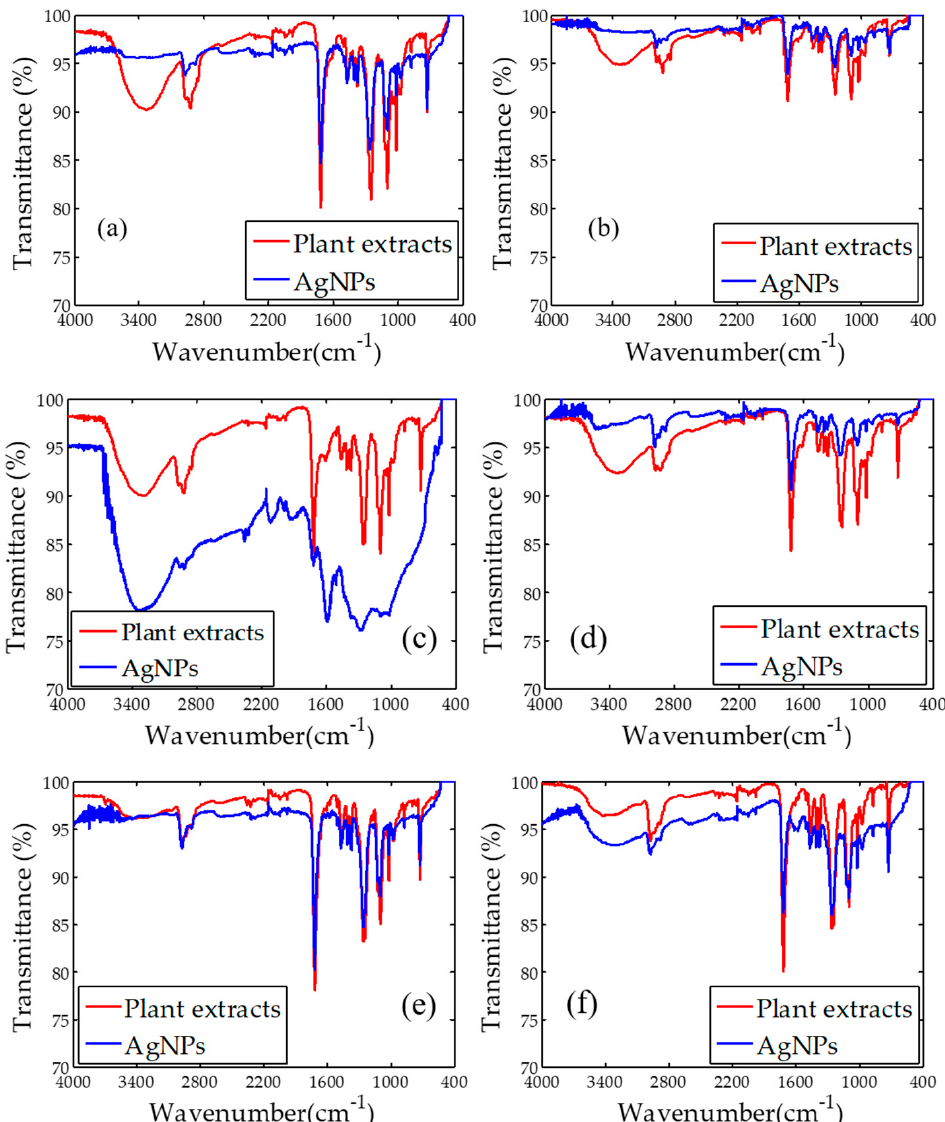
Figure 3. Fourier transform infrared spectroscopy (FTIR spectra) of plant extracts and AgNPs synthesized using ( a ) Cyperus rotundus ; ( b ) Eleusin indica ; ( c ) Euphorbia hirta ; ( d ) Melastoma malabathricum ; ( e ) Clidemia hirta ; and ( f ) Pachyrhizus erosus. Table 1. Biochemical contents of all employed plants.